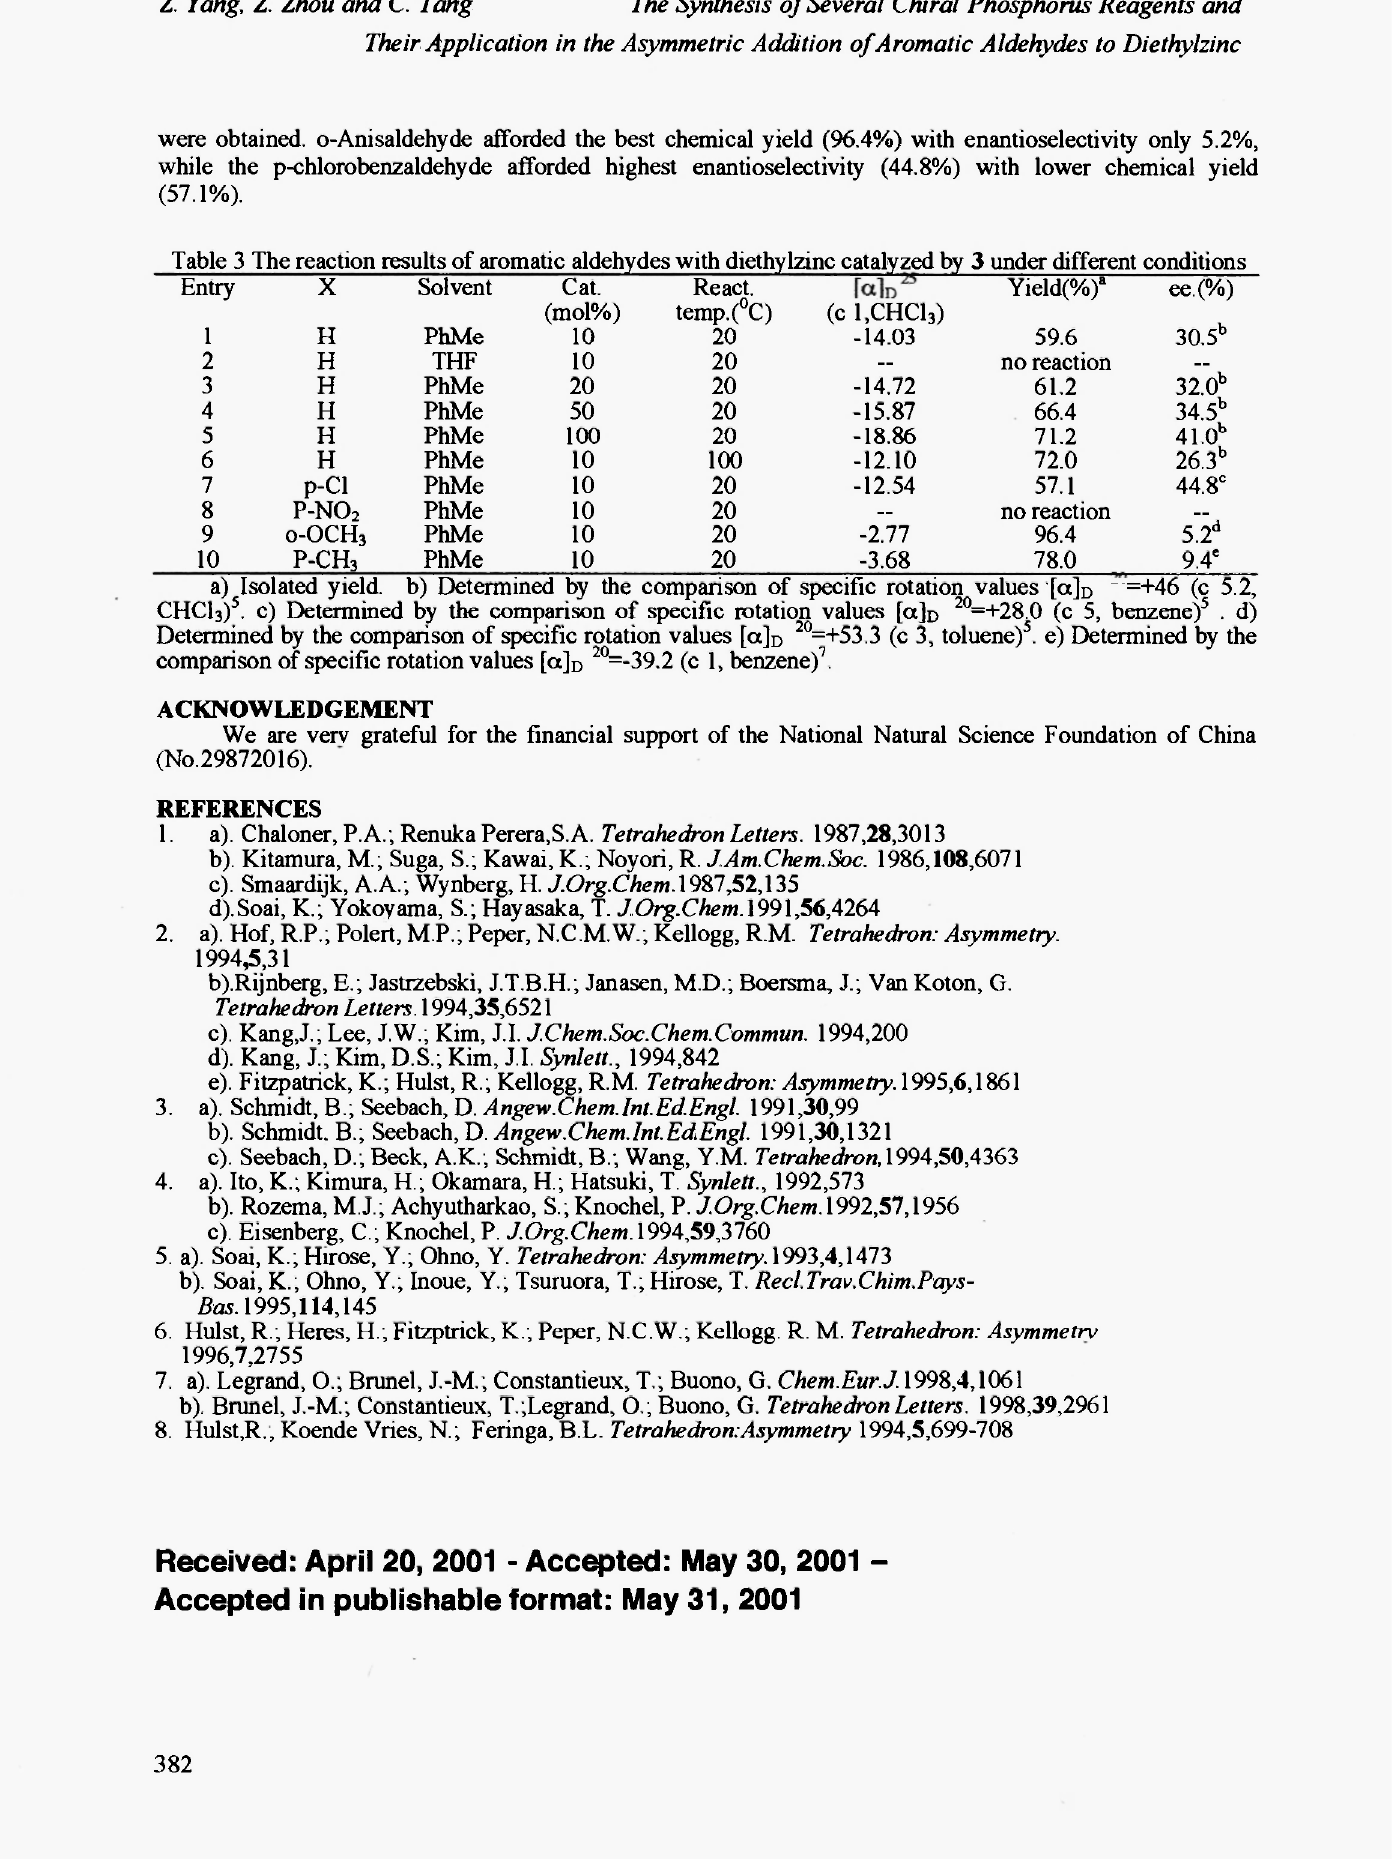
Table 3 The reaction results of aromatic aldehydes with diethylzinc catalyzed by 3 under different